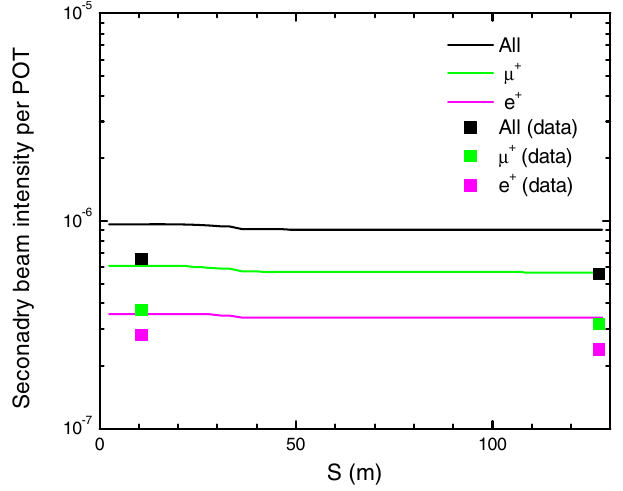
FIG. 13. Performance along the M4 and M5 lines. In black, the squares indicate the measured intensity at the entrance (IC902) and exit of the beam line (IC025), while the solid line shows the simulated total intensity for the baseline design parameters. With green and magenta, we show the corresponding rates of muons and positrons, respectively. At IC025, the simulation predicts a μ þ =e þ rate of 62 = 38 .